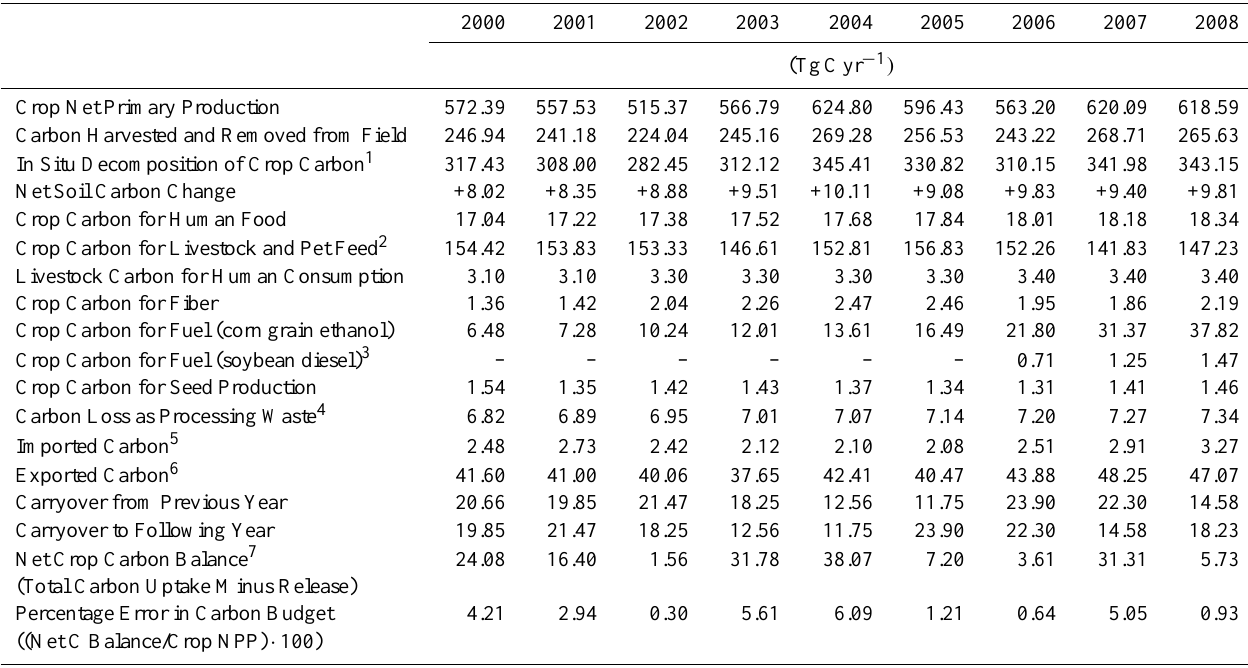
Table 3. Annual US crop carbon